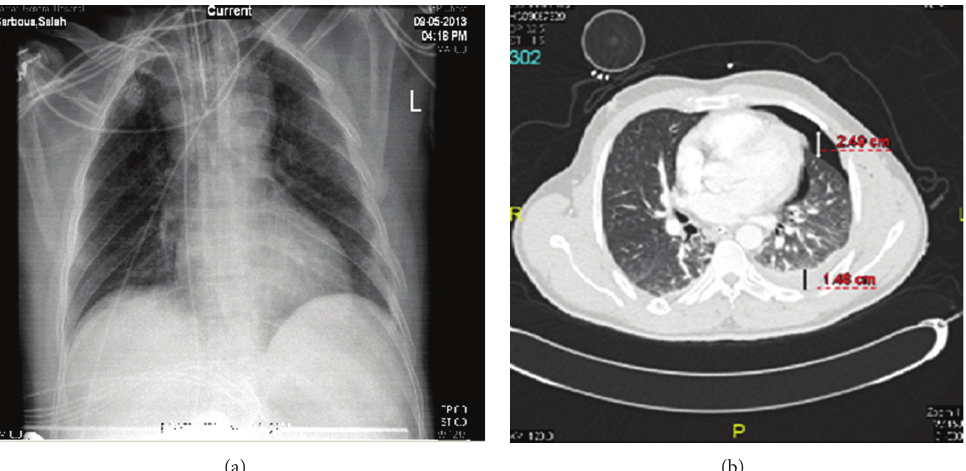
Figure 1: : (a) Chest radiograph and (b) corresponding CT scan of patient with 24mm pneumothorax and 14mm hemothorax on left side not identified on chest